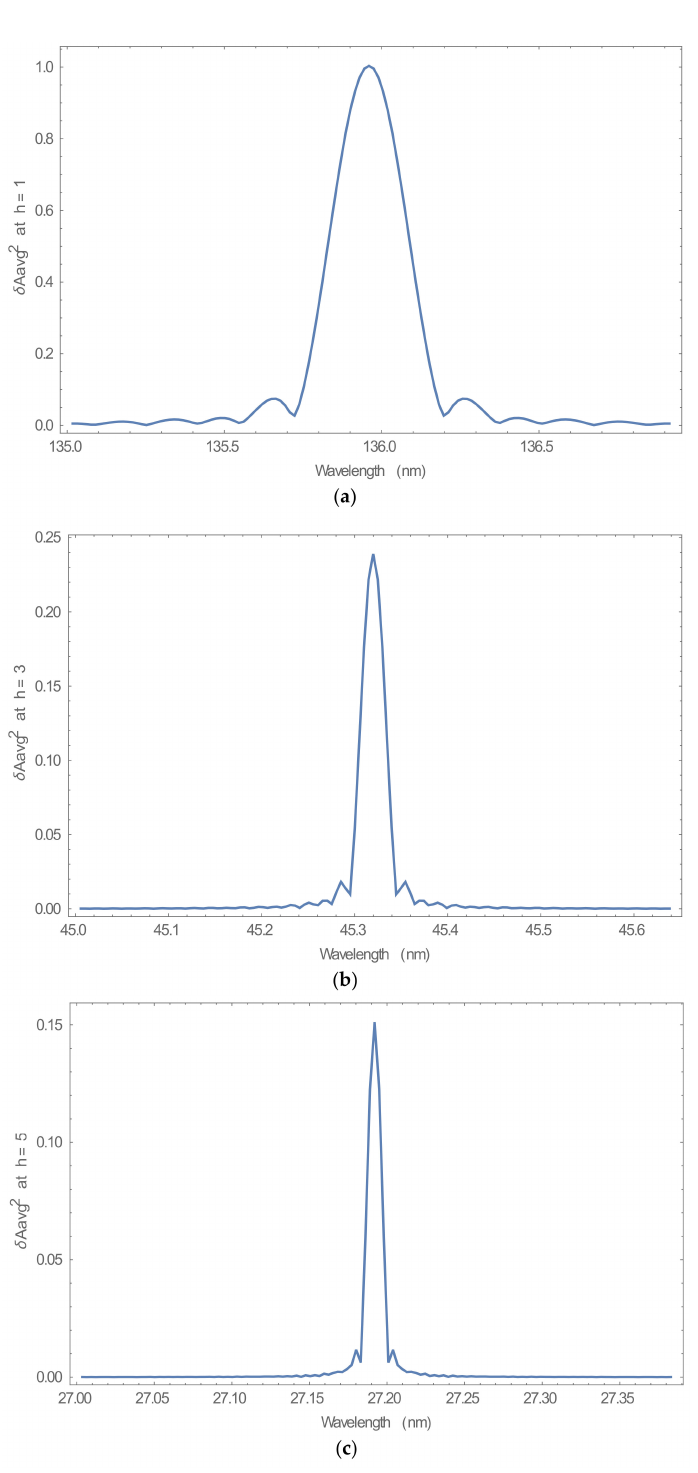
Figure 7. The evolution of the field intensity of polarized radiation for the wavelength with axial dis- tance for the fundamental and higher-order modes of h = 1 ( a ), 3 ( b ), and 5 ( c ) in the two-beam